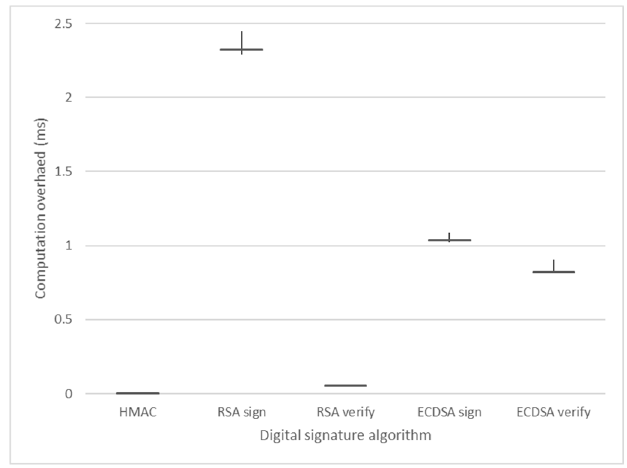
Figure 10. Digital signature benchmark result.